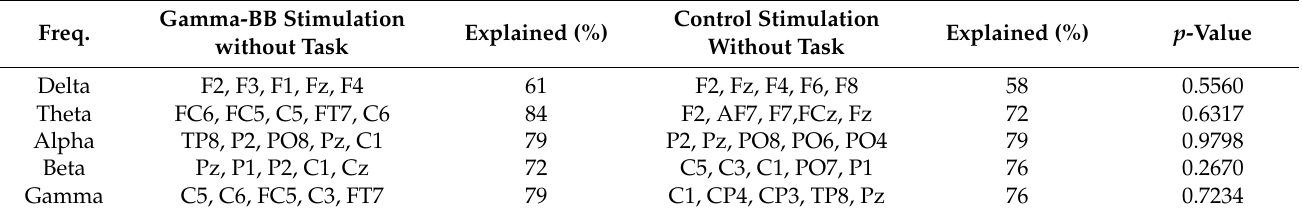
state across the bands (delta, theta, alpha, beta, and gamma).